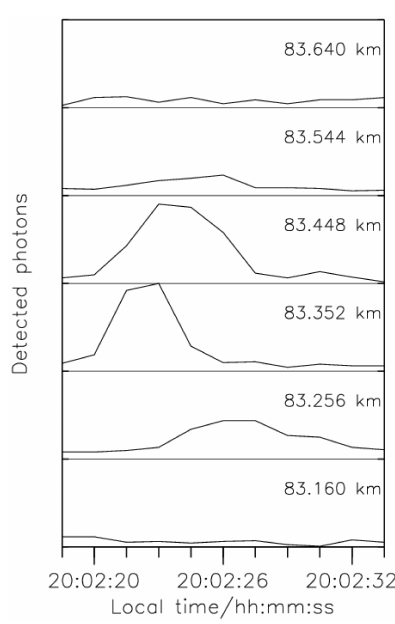
Figure 9. Temporal variation of the lidar returned signals at differ- ent altitudes, corresponding to Fig.